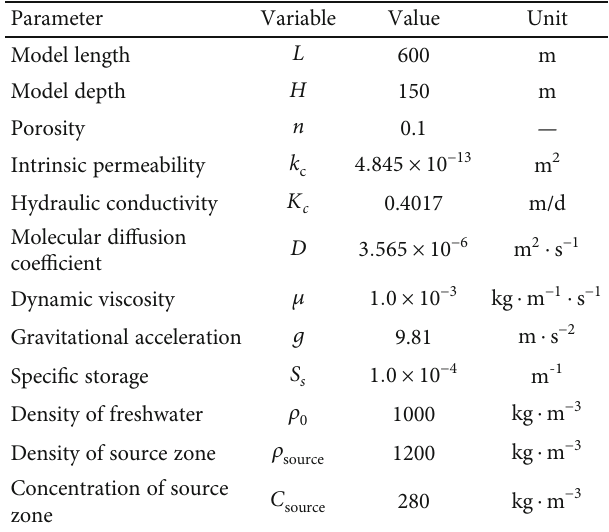
Table 1: Simulation parameters for the modi fi ed Elder problem